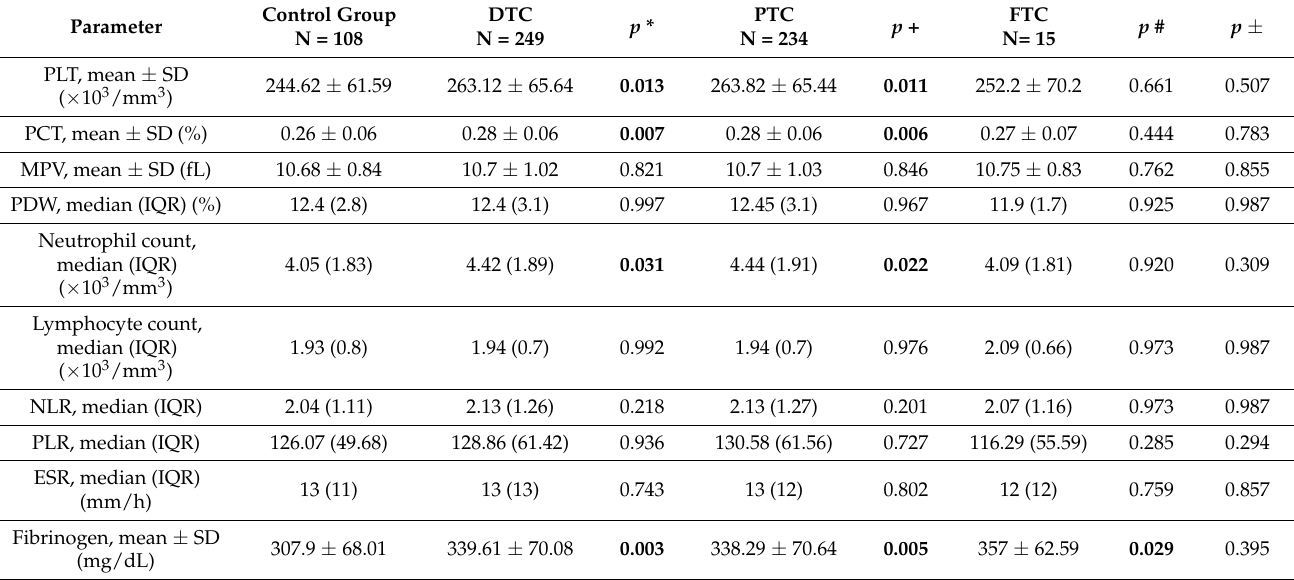
Table 2. Univariate comparative analysis of the inflammatory markers and platelet indices according to the type of DTC.